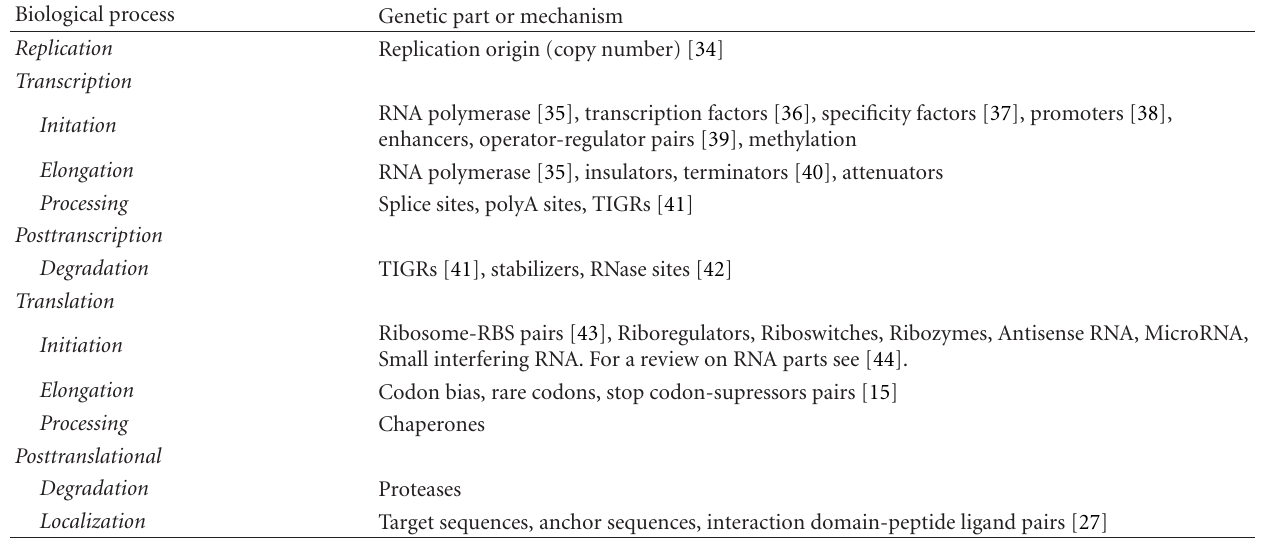
Table 1: Compilation of biological